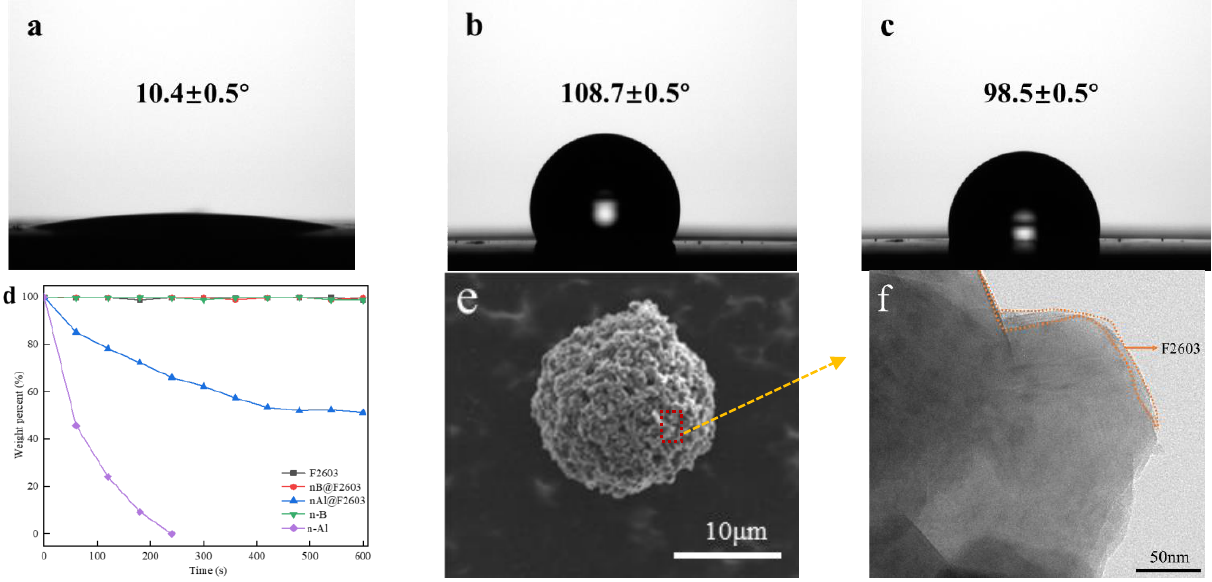
Figure 6. WCAs of ( a ) n-B, ( b ) F2603, and ( c ) nB@F2603 microspheres; ( d ) weight percentages of samples immersed in HCl solution for 10 min; ( e ) SEM images of nB@F2603 microspheres; ( f ) Local TEM images of nB@F2603